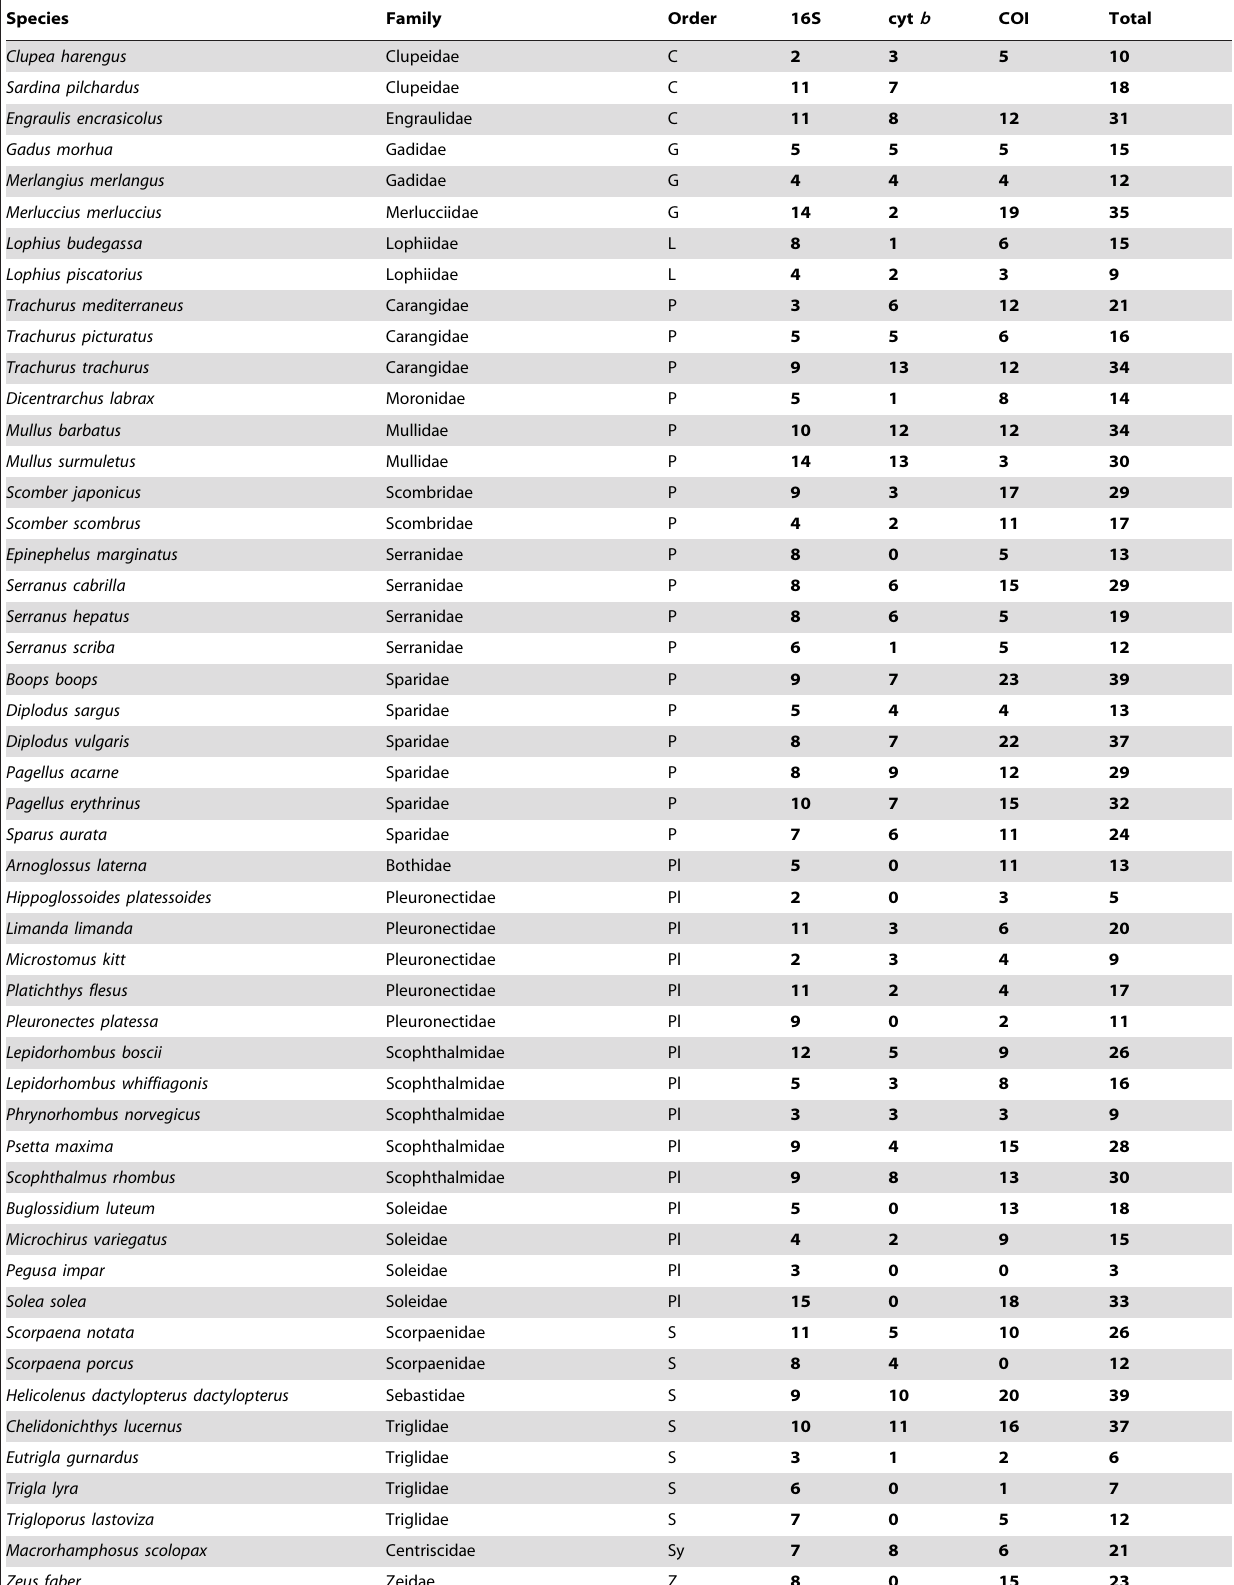
Table 1. Sequences utilised for the DNA barcoding